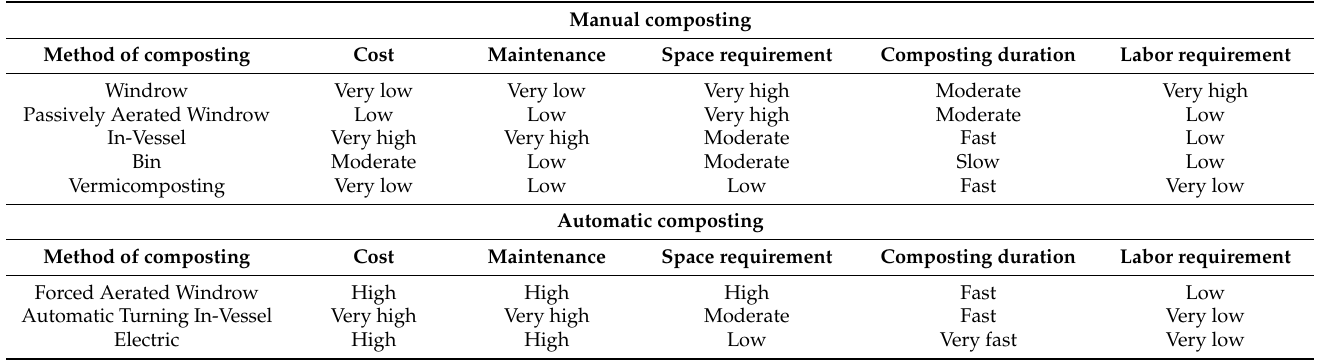
Table 4. Comparative summary between some of the manual and automatic composting methods. Manual